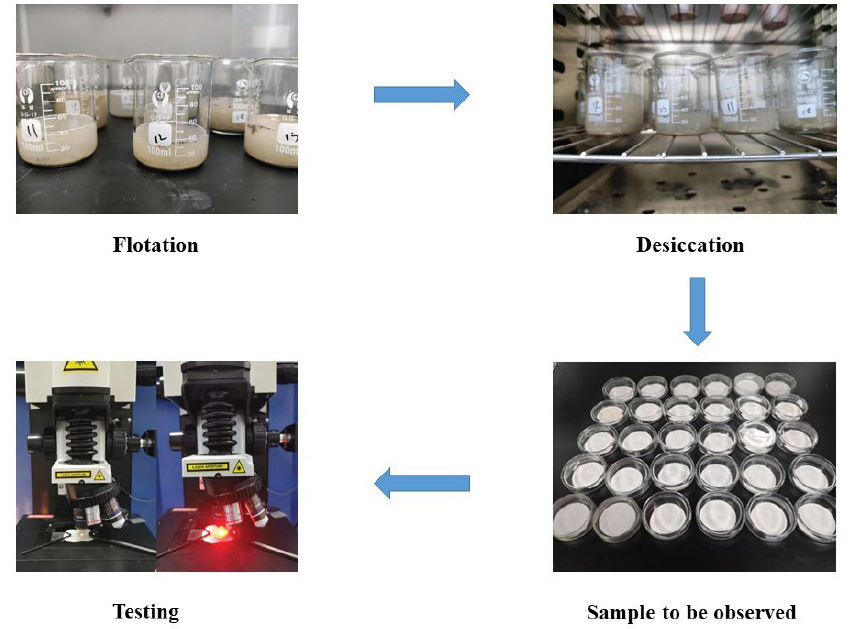
Figure 2. Process of extraction and testing of microplastics.